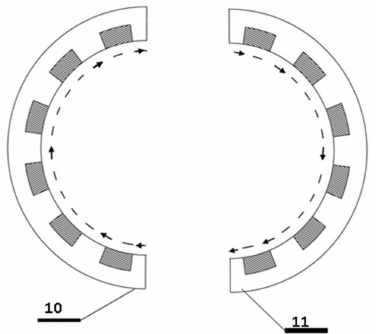
Figure 5. Front view of the “half” inductor-pairs with an open magnetic circuit; it was developed after separating the pole pairs, being on the ”A” (“10”) and ”B” (“11”) side from each other.